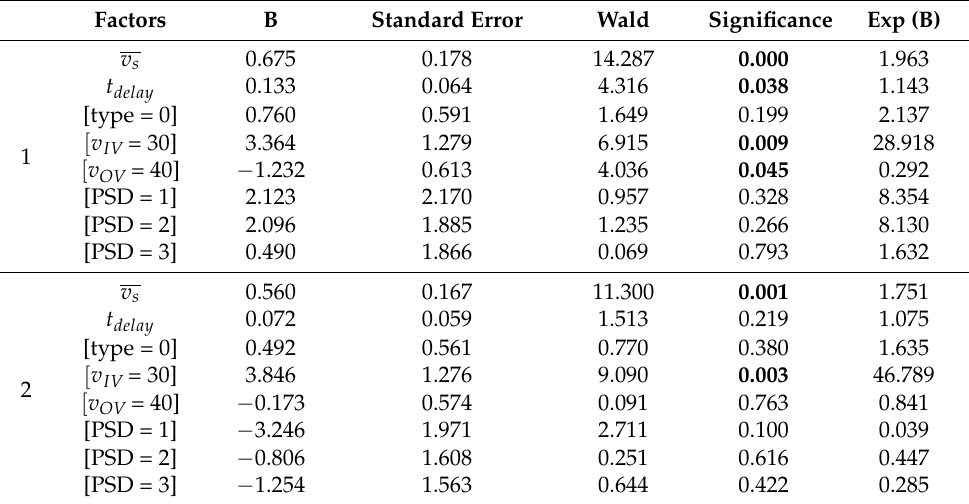
Table 4. Results from the multi-class logistic